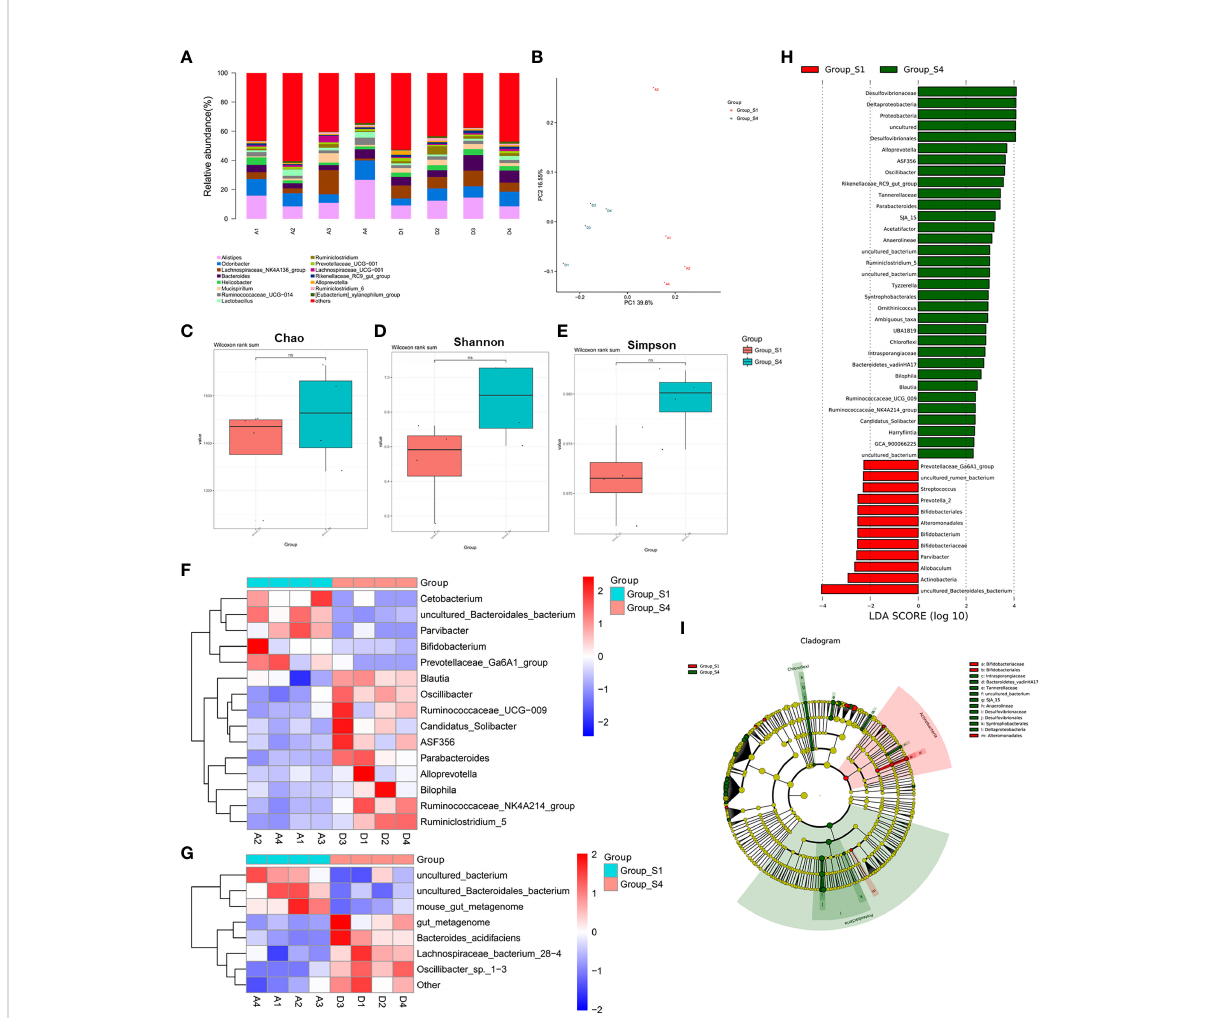
FIGURE 4 WJR modulated the gut microbiome composition. (A) Bar plot of the phylogenetic composition of gut microbiome at the genus level. (B) PCoA in different groups (A1-4, S1 group; D1-4, S4 group). Alpha diversity of the gut microbiome between the control group and the high dose of the WJR group based on (C) Chao, (D) Shannon and (E) Simpson indices. (F) Wilcoxon rank-sum test was performed for bacterial taxa at the genus level (G) and species level. (H) LEfSe analysis. (I) Taxonomic cladogram from LEfSe. S1, control group; S4, high-dose of WJR group; WJR, Wenzi Jiedu Recipe. ns, not signi fi